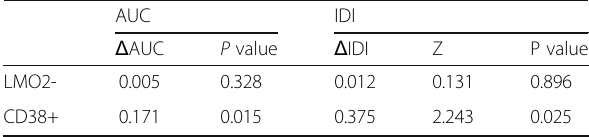
Table 4 Comparison of the diagnostic efficacy between combination of LMO2( − ) and CD38(+) and single index AUC IDI Δ AUC P value Δ IDI Z P value LMO2- 0.005 0.328 0.012